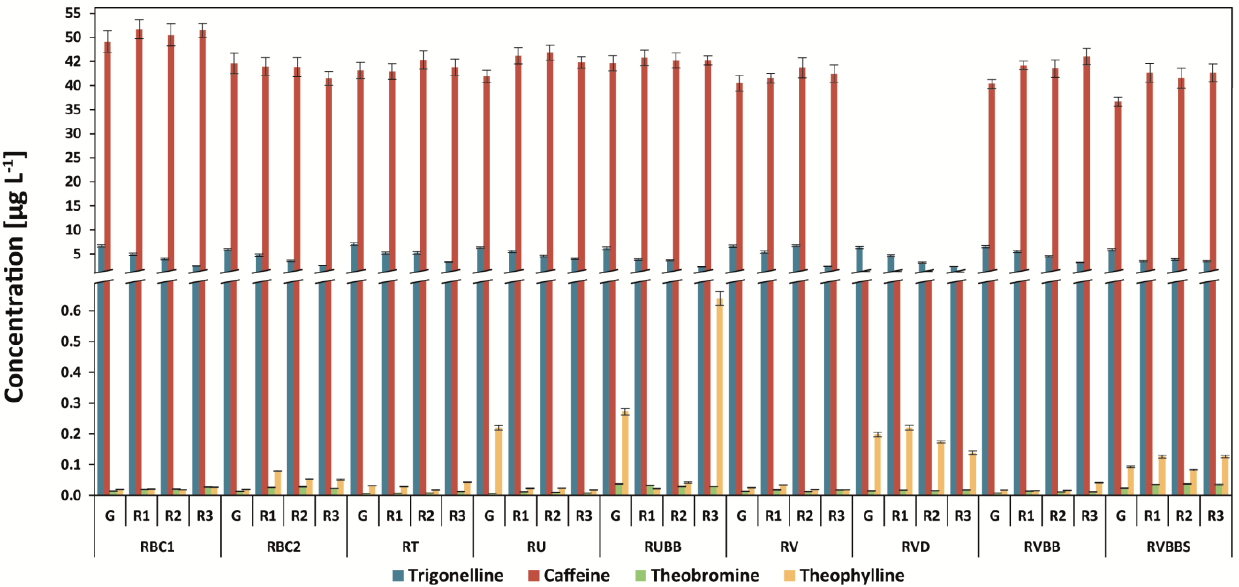
Figure 4. Methylxanthines and trigonelline content in Robusta coffee brews. Legend — Figure 1 cap- ture .